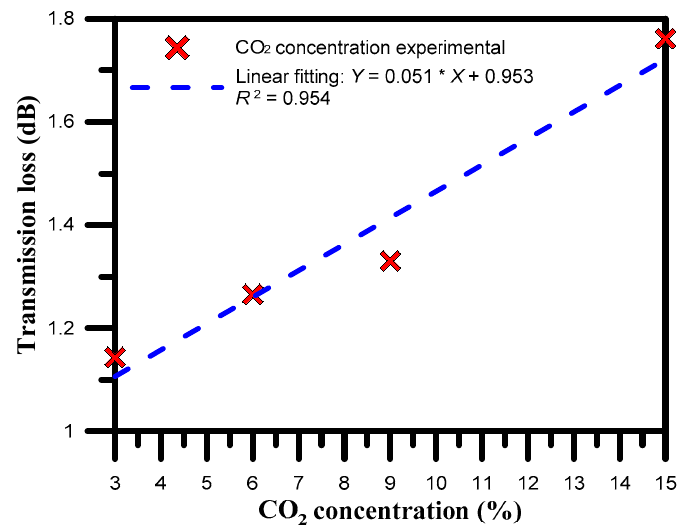
Figure 7. Correlation between CO 2 concentration and transmission loss.